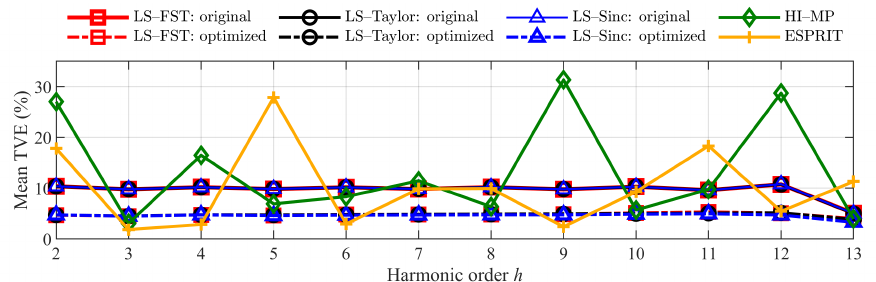
Figure 12. The mean TVE of LS-FST, LS-Taylor, and LS-Sinc with and without the proposed optimiza- tion, as well as the HI-MP and ESPRIT methods under frequency ramp